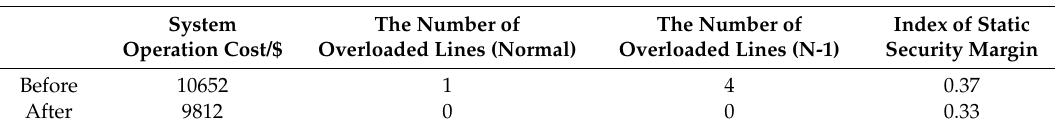
Table 9. The comparison of system economic efficiency and static security index before and after optimization in Case B.